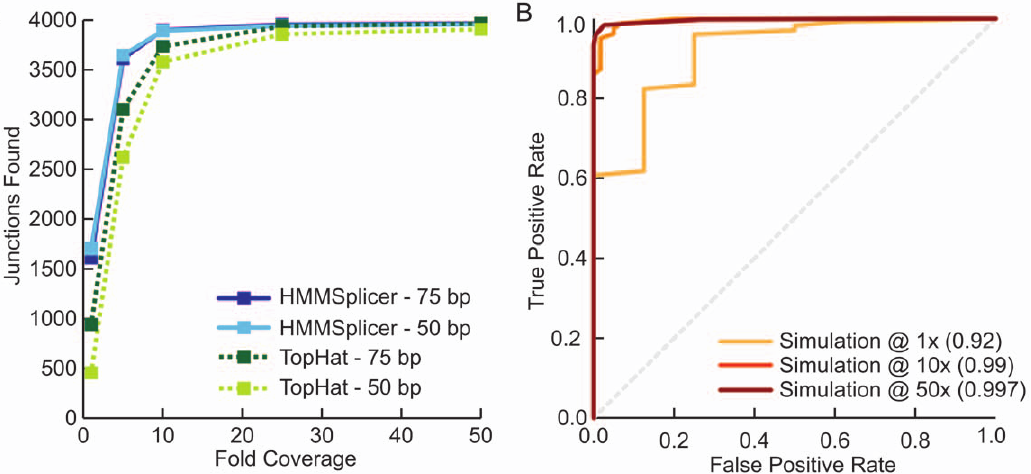
Figure 3. Simulation results. ( a ) Results for HMMSplicer and TopHat for 50 and 75 bp reads. Although values are similar at higher coverage levels, HMMSplicer exhibits substantial increases in sensitivity at lower coverage levels. ( b ) ROC curve for the 50 bp simulation results at 1 6 , 10 6 , and 50 6 coverage demonstrates that HMMSplicer’s scoring algorithm accurately discriminates between true and false junctions. The number in parentheses is the area under the curve for each coverage